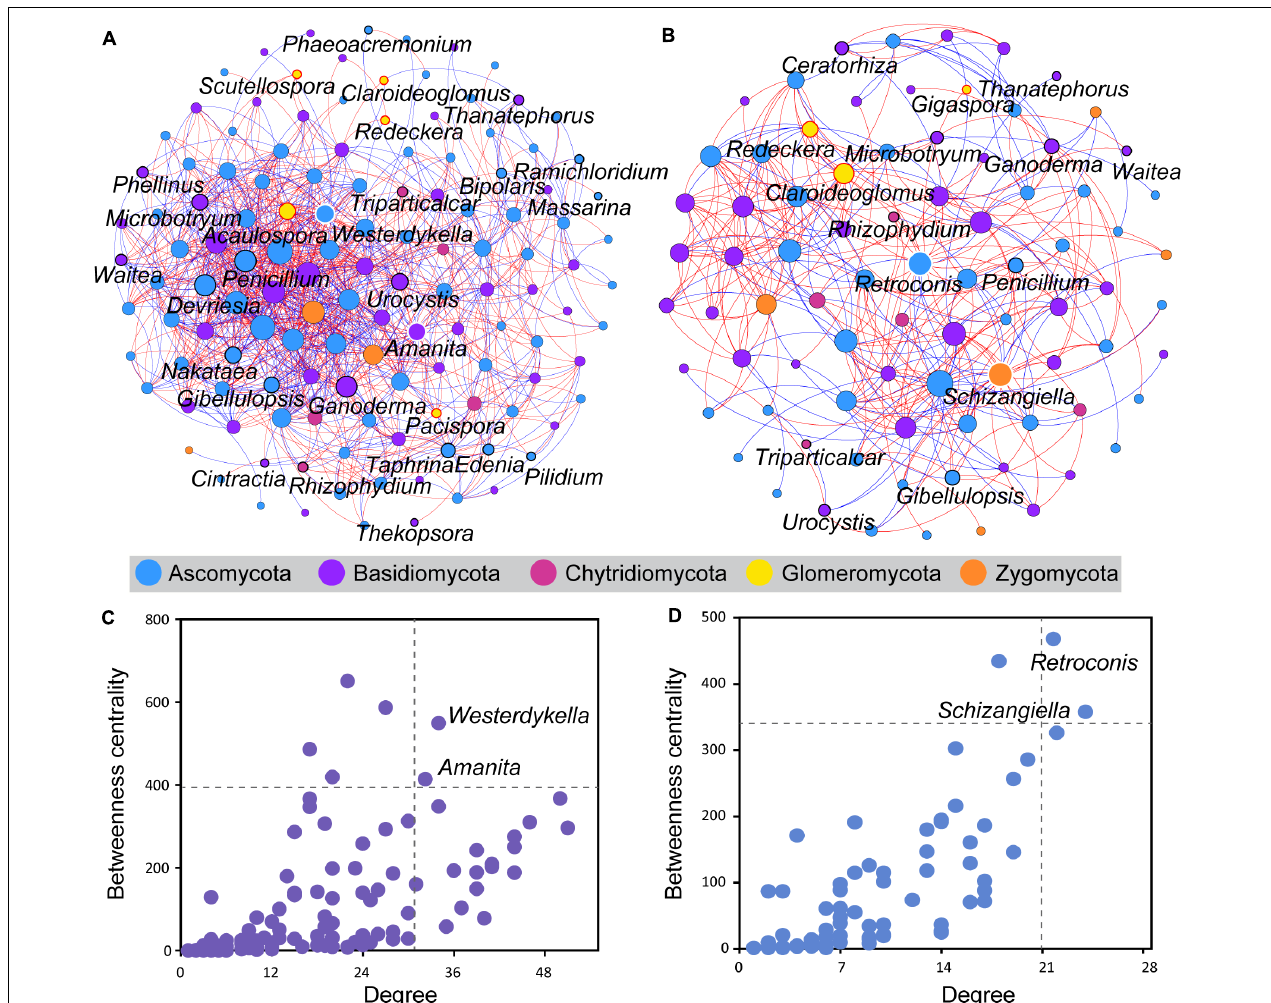
FIGURE 4 | Co-occurrence analysis of the rhizosphere fungal community of wild and domesticated rice. The co-occurrence networks of the rhizosphere fungal community of wild (A) and domesticated (B) rice were constructed based on the SparCC correlation coefficients. An edge stands for a significant positive correlation (SparCC r > 0.5, P < 0.05, red line) or significant negative correlation (SparCC r < –0.5, P < 0.05, blue line). The nodes represent taxa affiliated at the genus level with at least one significant correlation. The size of the node is proportional to the degree (the number of connections). Each node was colored by phyla. The nodes circled by red, white, and black outlines are arbuscular mycorrhizal fungi, hub fungi, and potential plant pathogens, respectively. The nodes representing hub fungi taxa were labeled. The hub taxa of the rhizosphere fungal community of wild (C) and domesticated (D) rice were nodes showing a high degree and betweenness centrality. The dashed lines indicated the threshold values (top 2%). The nodes representing hub fungi taxa were